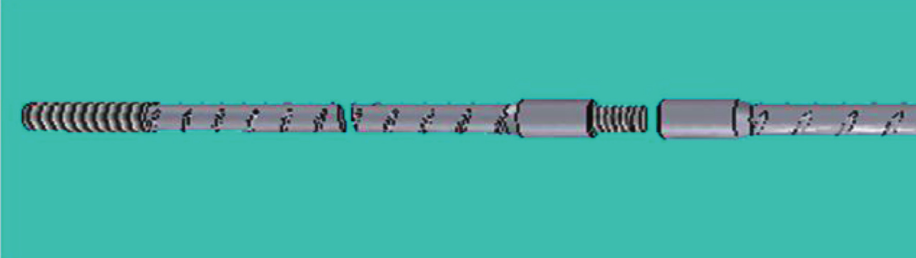
Figure 14: Schematic diagram of the long anchor